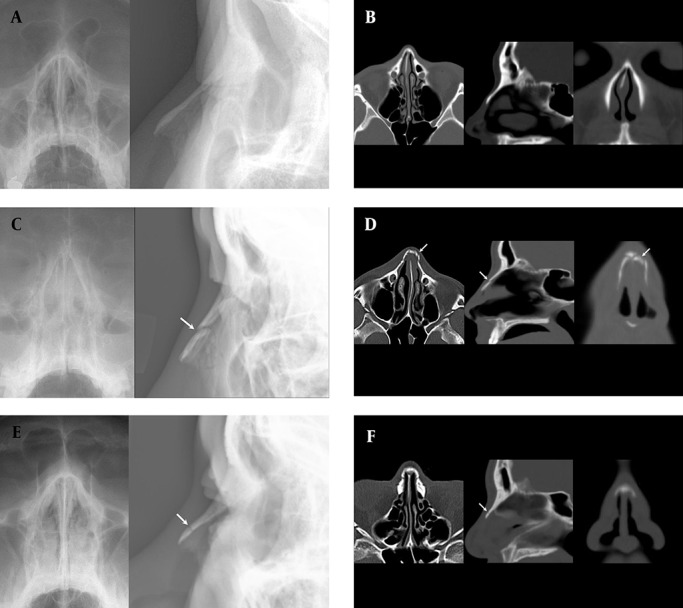
Three slices of the nasal bone are shown: A and B, a 28-year-old man with no fracture (A: coronal and lateral conventional radiography images, B: axial, sagittal, and coronal reformatted CT images). C and D, a 24-year-old man with depressed fracture (C: coronal and lateral conventional radiography images, D: axial, sagittal, and coronal reformatted CT images). E and F, a 42-year-old man with non-depressed fracture (E: coronal and lateral conventional radiography images, F: axial, sagittal, and coronal reformatted CT images) (arrows indicate nasal bone fracture).